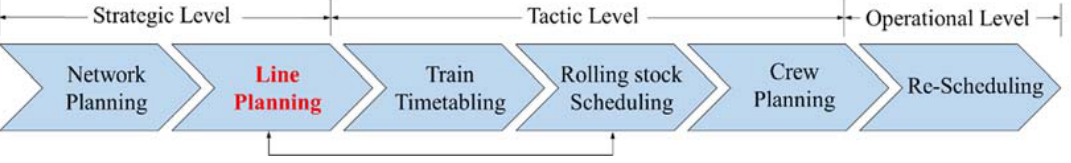
Figure 1. Illustration of railway planning procedures.